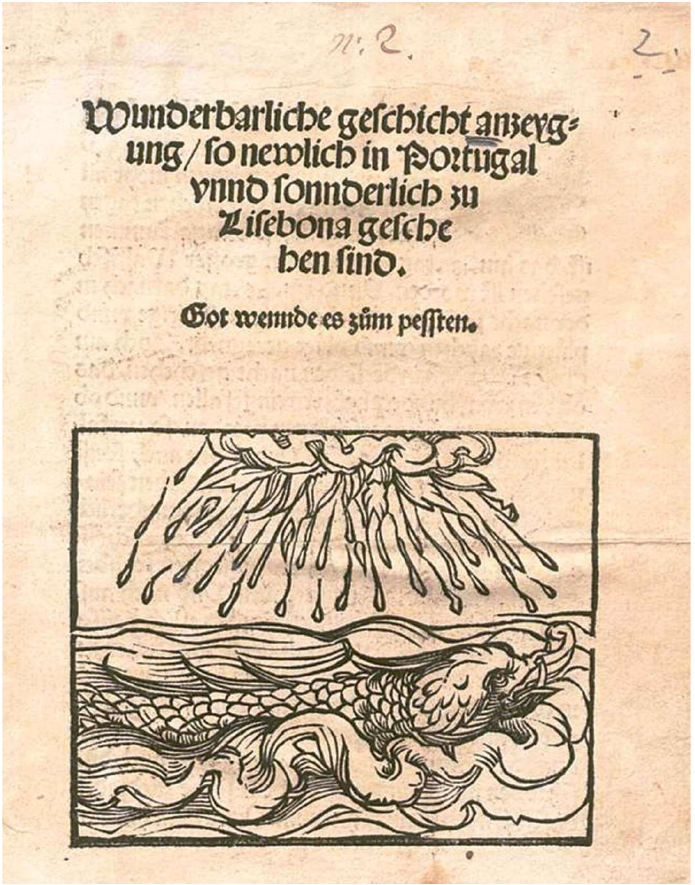
Figure 2. First page of a German leaflet showing the so-called Whale of Augsburg or the stranded whale in Lisbon in January of 1531: http://daten.digitale-sammlungen.de/~db/bsb00008463/images.